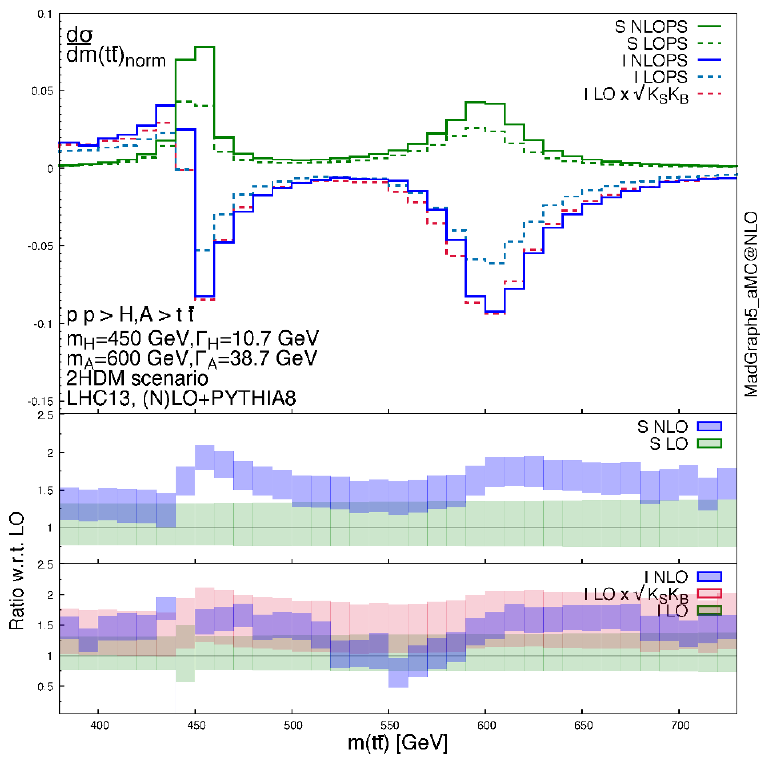
Figure 17 . Signal and interference lineshapes at (N)LO matched with PS for LHC 13 TeV. Re- sults are normalised to the SM fNLO lineshape. Lower panels show the K-factors and the scale uncertainties of signal and interference